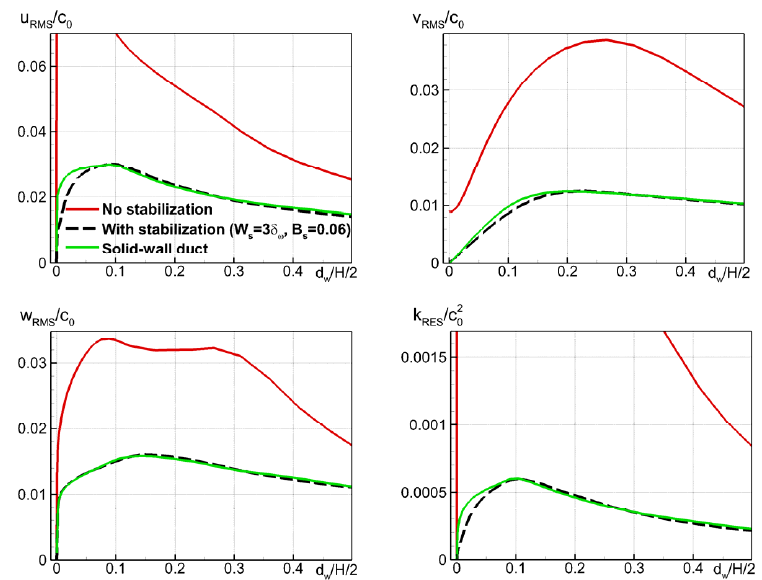
Figure 19. Effect of stabilization (10) with optimal parameters on wall-normal profiles of root-mean- square pulsations of velocity and resolved TKE at x = 0.6 m.